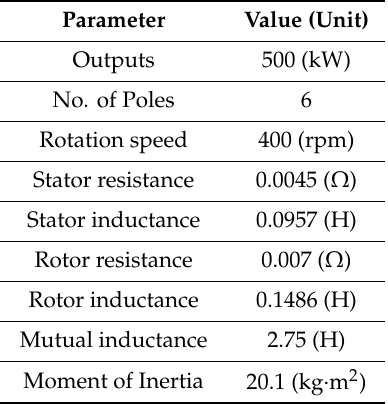
Table 3. Motor specification (courtesy of Hyosung Heavy Industry Ltd., Seoul,